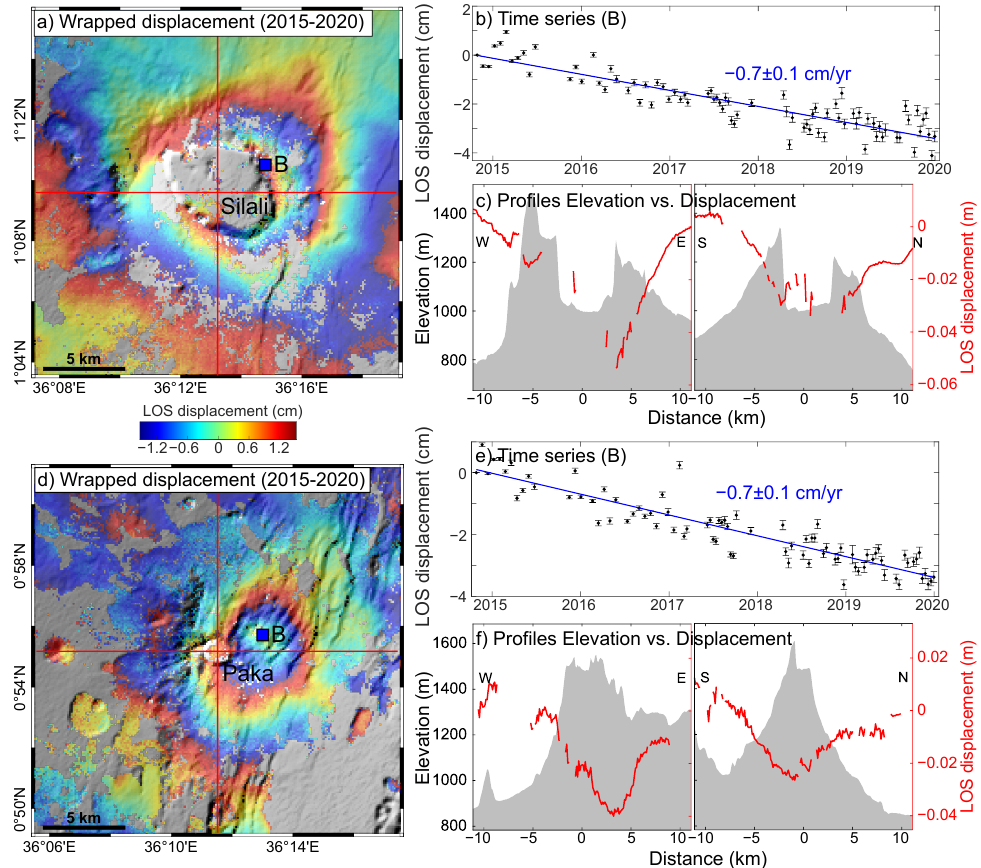
Figure 8. LOS displacement detected at the two Kenyan volcanoes, ( a – c ) Silali and ( d – f ) Paka, ( a , d ) wrapped cumulative displacements (LOS) for the 5-year time period (2015–2020), ( b , e ) time series of LOS displacements at the location B, ( c , f ) comparison between the profiles of displacements (red lines) and the topography (shaded area) along W-E (left) and S-N (right) directions. However, the categories provided by the empirical time-series fits do not directly correspond with the process-based categories of Albino and Biggs [9]. The ’sigmoidal’ classification represents a range of processes: the signals at Fentale and Erta Ale have been attributed to dyke intrusions [51,52], while Suswa, Tullu Moje and Olkaria are considered to be restless calderas [7]. For Erta Ale, the sigmoid fit is poorer than for the other